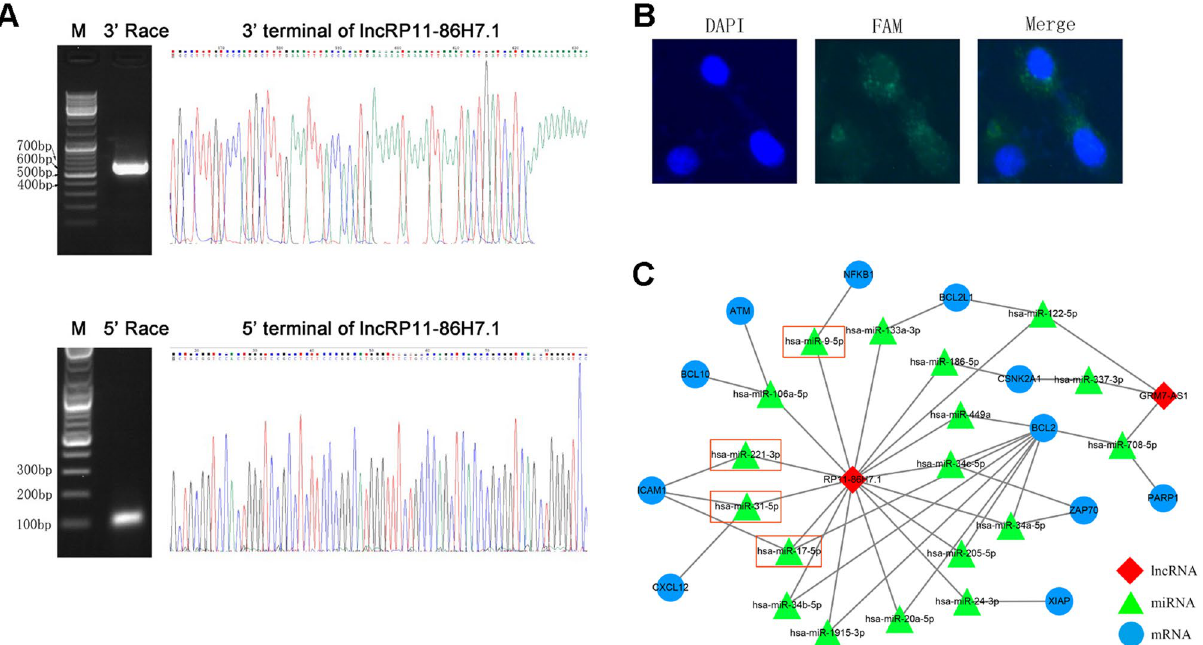
Figure 4. Full-length sequence, coding ability, subcellular distribution and coexpression network characteristics of the lncRNA RP11-86H7.1. ( A ) 5 ′ -RACE and 3 ′ -RACE assays were performed to determine the transcriptional initiation and termination sites of the lncRNA RP11-86H7.1. Left, representative images of the PCR products obtained by 5 ′ -RACE and 3 ′ -RACE. Right, the sequence of the second-round PCR products revealed the boundary between the universal anchor primer and the lncRNA RP11-86H7.1 sequence. ( B ) FISH analysis of the subcellular distribution of the lncRNA RP11-86H7.1 in 16HBE cells. Scale bar 20 μm. ( C ) Co-expression network characteristics of the lncRNA RP11-86H7.1. FAM refers to carboxyfluorescein, FAM-labeled lncRNA RP11-86H7.1 was stained green (FAM), and nuclei was stained blue with 6-diamidino-2- phenylindole